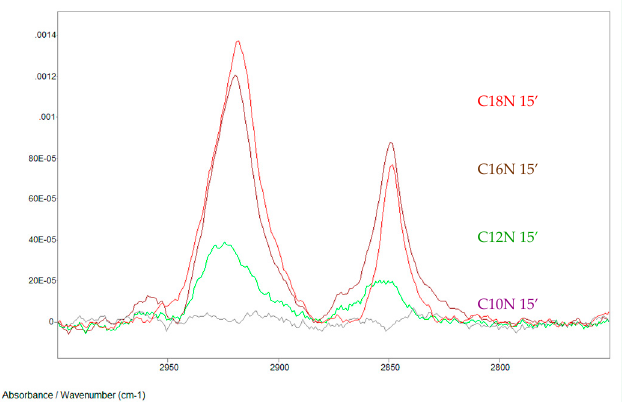
Figure 4. Hydroxamic acids with increasing alkyl chains in self-assembled nanolayers on copper surface; formation time:15 min (C10N: decanoyl hydroxamic acid; C12N: dodecanoyl hydroxamic acid; C16N: palmitoyl hydroxamic acid; C18N: stearoyl hydroxamic acid; the notation e.g. in case of C18N 15’ means that the layer is stearoyl hydroxamic acid SAM formed in 15 min. IRRAS, 0°